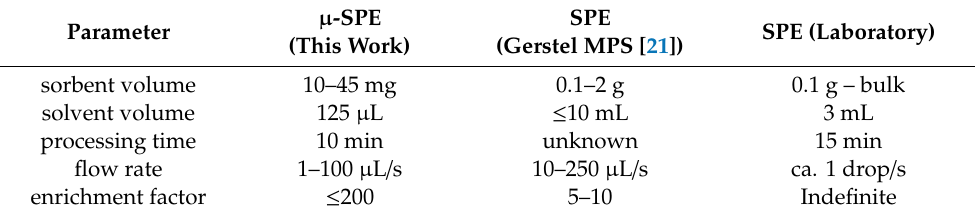
Table 4. Comparison of µ -SPE and standard